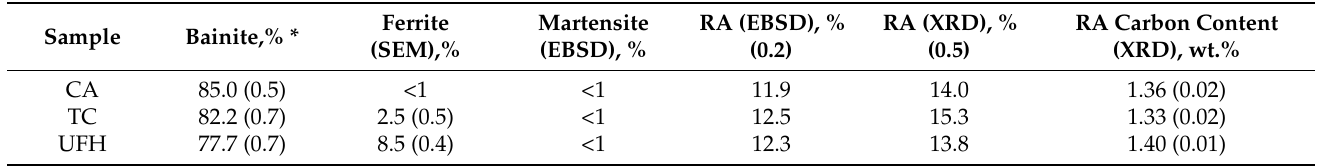
Figure 5. ( a , d , g ) CA, ( b , e , h ) TC and ( c , f , i ) UFH. Microstructures obtained after isothermal holding at 400 °C for 600 s: The first row of images presents the inverse pole figure of the reconstructed PAGs. EBDS IQ-Phase maps and secondary electron images are shown in the second and third row of images, respectively. Retained austenite grains (FCC) appear highlighted in green in the combined IQ-Phase maps, while bainite, ferrite and martensite appear red. White and black lines delineate boundaries of misorientation angle between 5–15° and 15–63°, respectively. M: Martensite; γ: Retained austenite of film (γ F ) and blocky-type (γ B ) morphologies. M/γ: martensite-retained austenite constituent; θ: undissolved cementite particles. Note that the magnification increases from the first to the third row of images. Table 2. Microconstituents quantification (standard